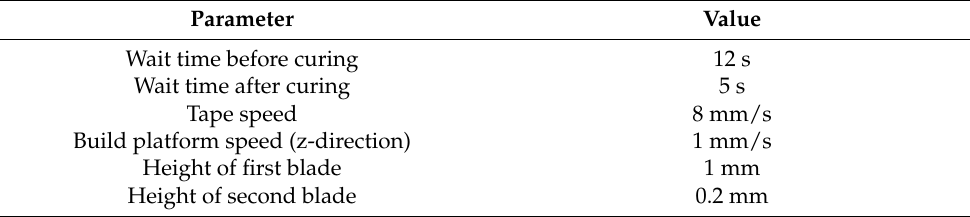
Table 1. Several parameters used for